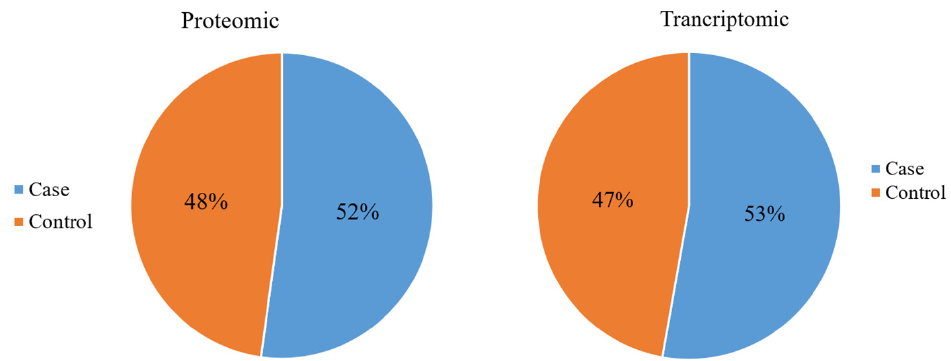
Figure 2. The percentage of PD patients (“case”) and controls from the included proteomic and transcriptomic studies.